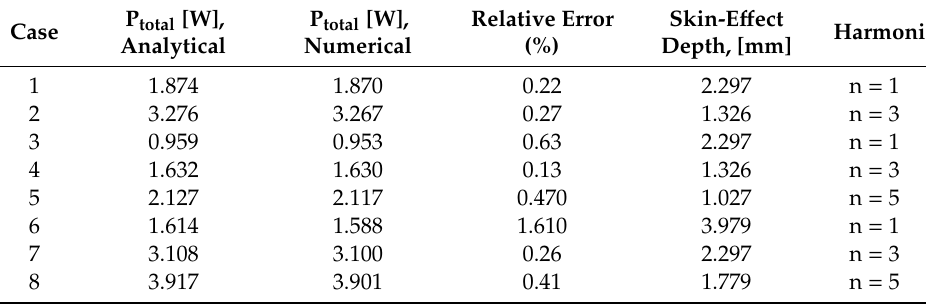
Table 2. Total stray losses in the disk ( µ r = 200